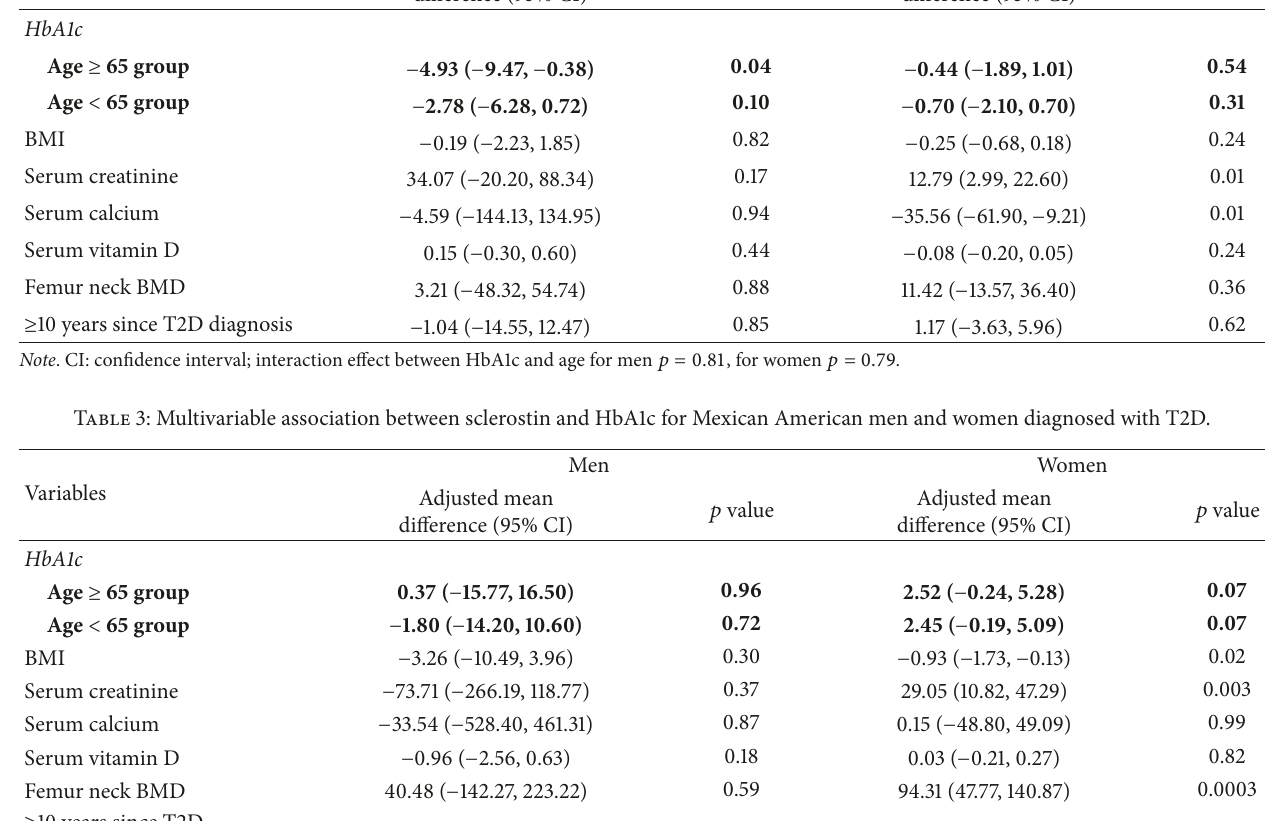
Table 2: Multivariable association between osteocalcin and HbA1c for Mexican American men and women diagnosed with T2D. Variables